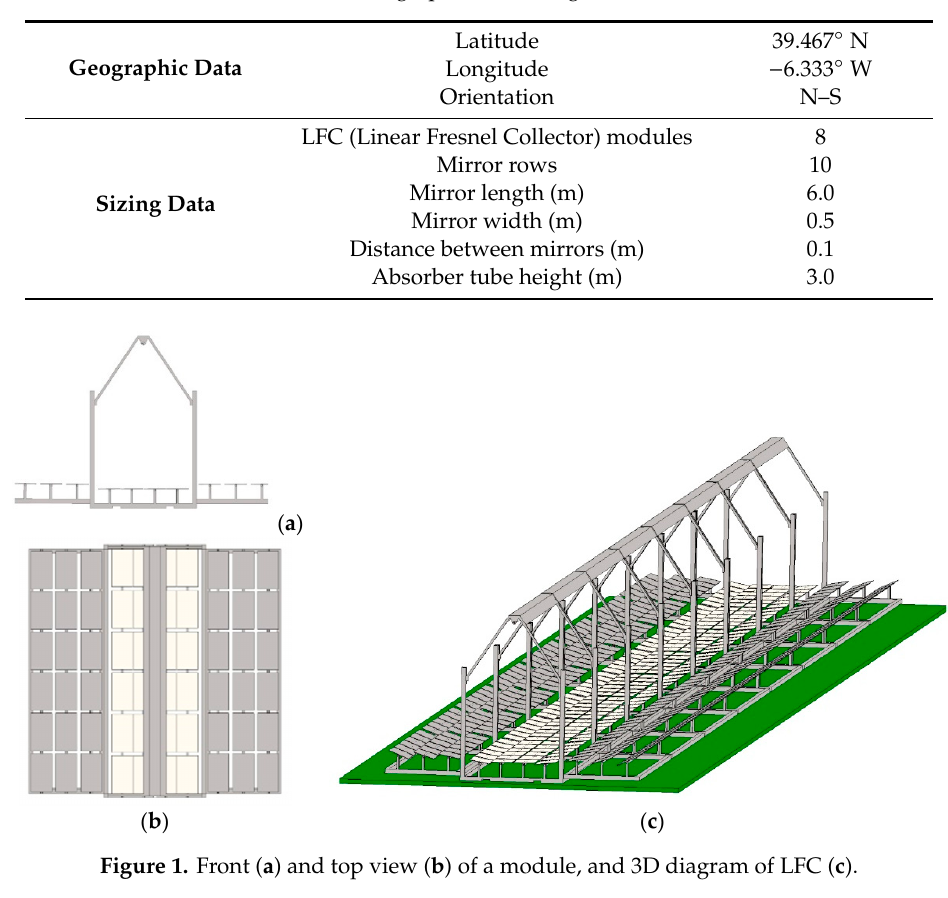
Table 3. Geographic and sizing data used.